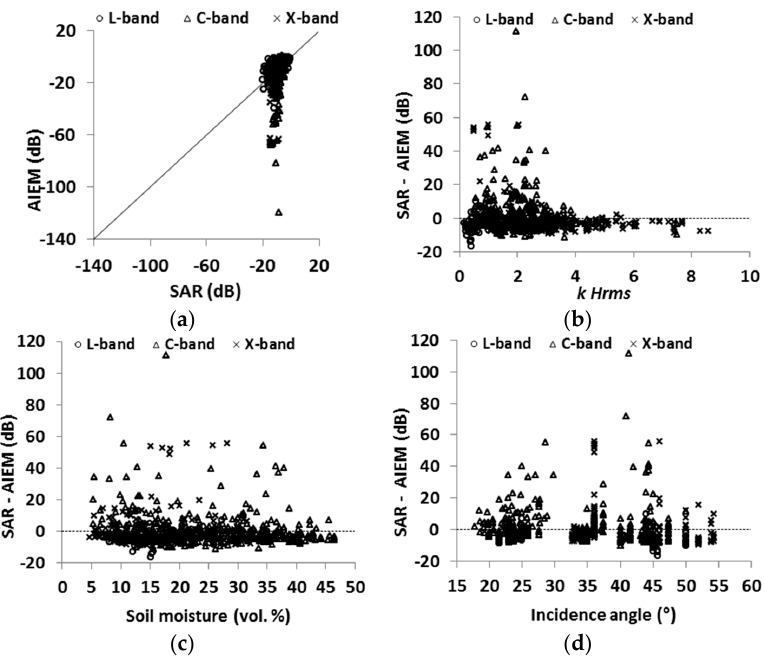
Figure 16. Comparison between backscattering coefficients derived from SAR images and those estimated from AIEM at VV polarization using GCF. ( a ) AIEM simulations vs. SAR data; ( b ) difference between SAR signal and AIEM vs. soil roughness ( kHrms ); ( c ) difference between SAR signal and AIEM vs. soil moisture ( mv ); ( d ) difference between SAR signal and AIEM vs. incidence angle.